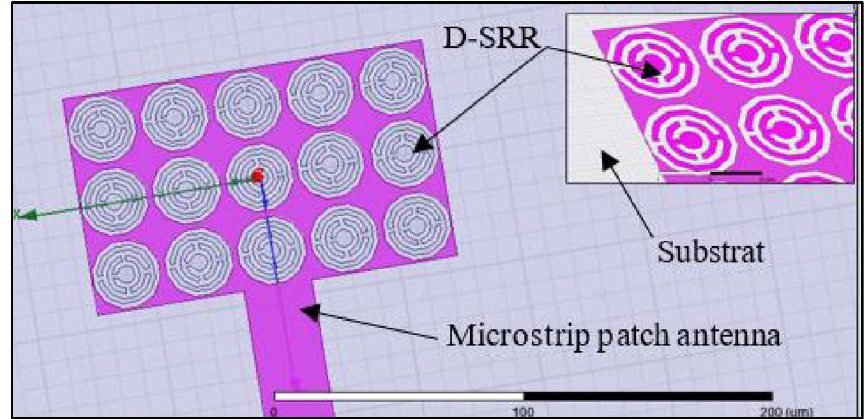
Fig. 13 Proposed shape of periodic arrays of the D-SRR in HFSS